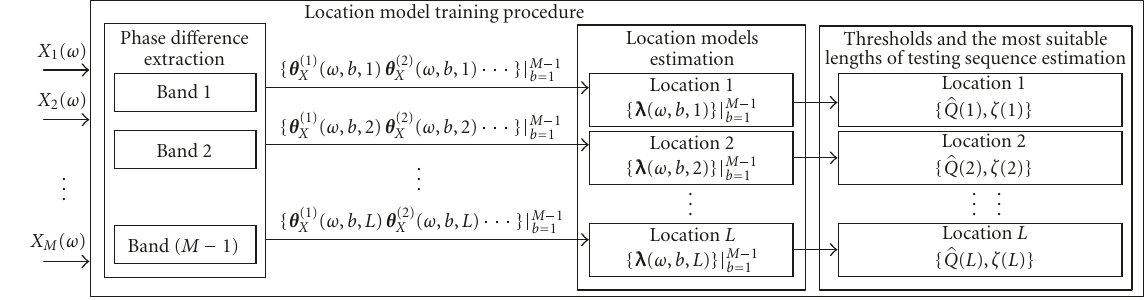
Figure 3: GM location model training procedure.